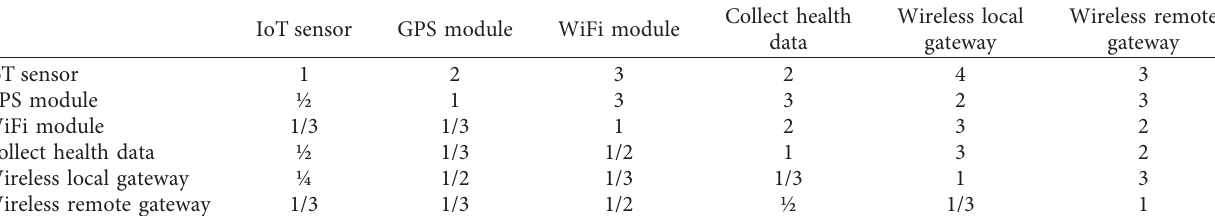
Table 3: Details of components for architecture 2.